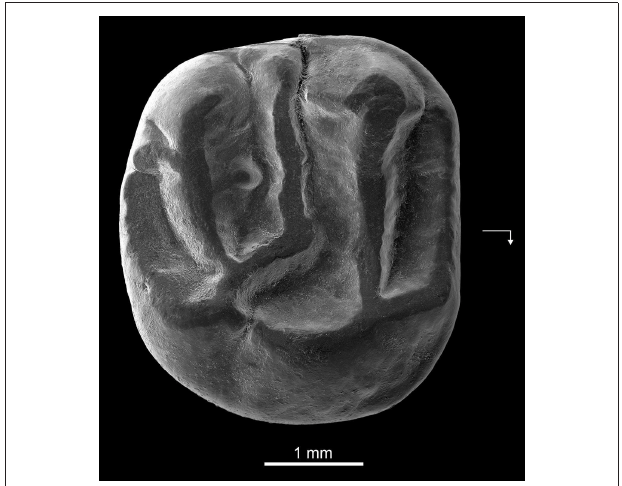
FIGURE 4 | Kabirmys prius , new species, DT3-1, New Idam Unit, late middle Eocene, Dur At-Talah escarpment, south-central Libya. Holotype right M 2 in occlusal view. Arrow points mesially and lingually to indicate